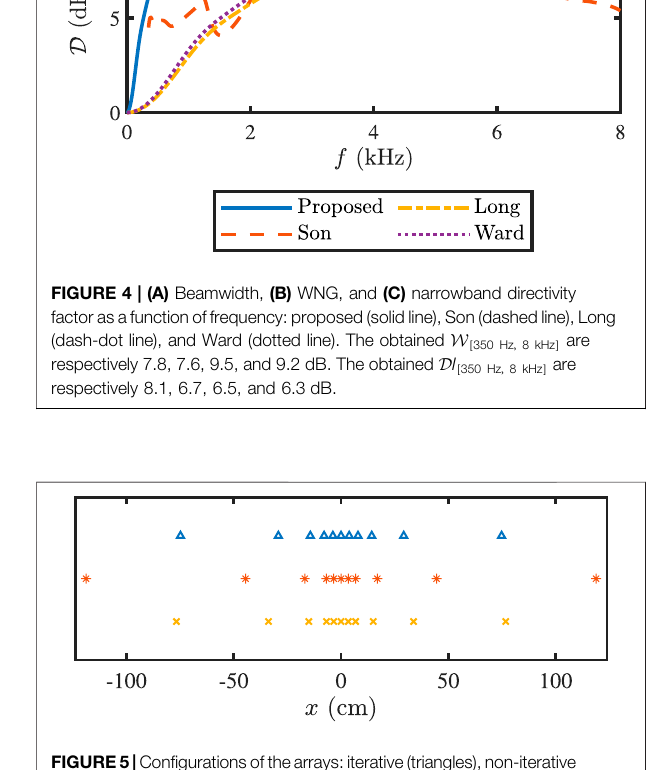
FIGURE5| Con fi gurationsofthearrays:iterative(triangles),non-iterative with β min = 0 (asterisks), and non-iterative with β min = 1.36